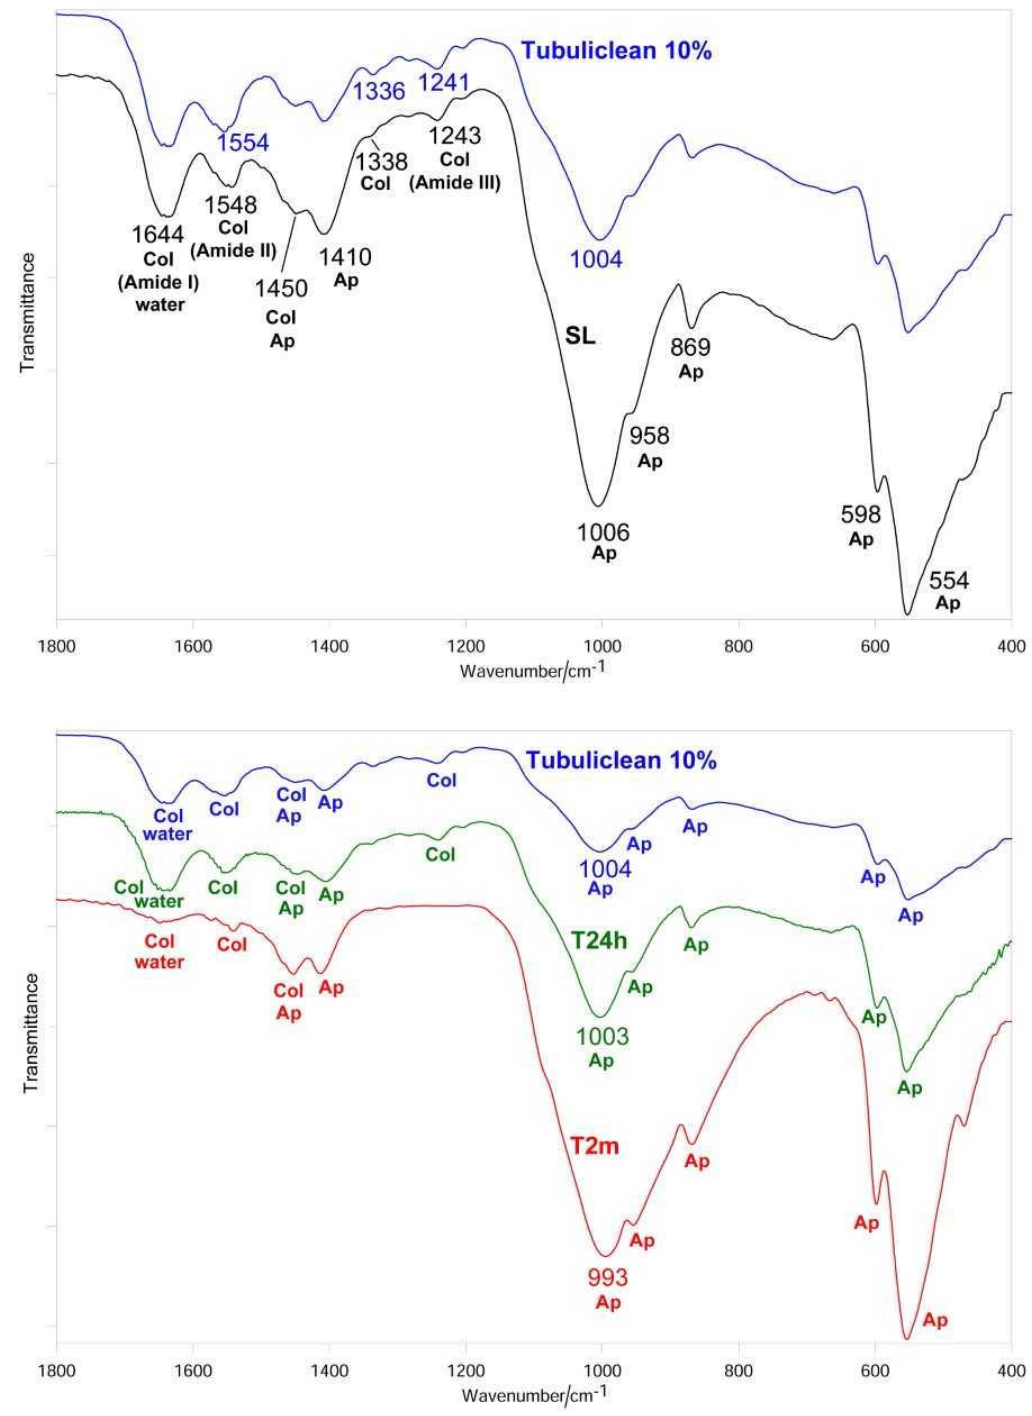
Figure 7. Average IR spectra recorded on the dentin surface after sanding (SL, black), treatment with 10% EDTA (Tubuliclean 10%) (blue), aging in SBF for 24 h (T24h, green) and two months (T2m, red). The bands prevalently assignable to collagen (Col), water, and B-type carbonated apatite (Ap) are indicated.